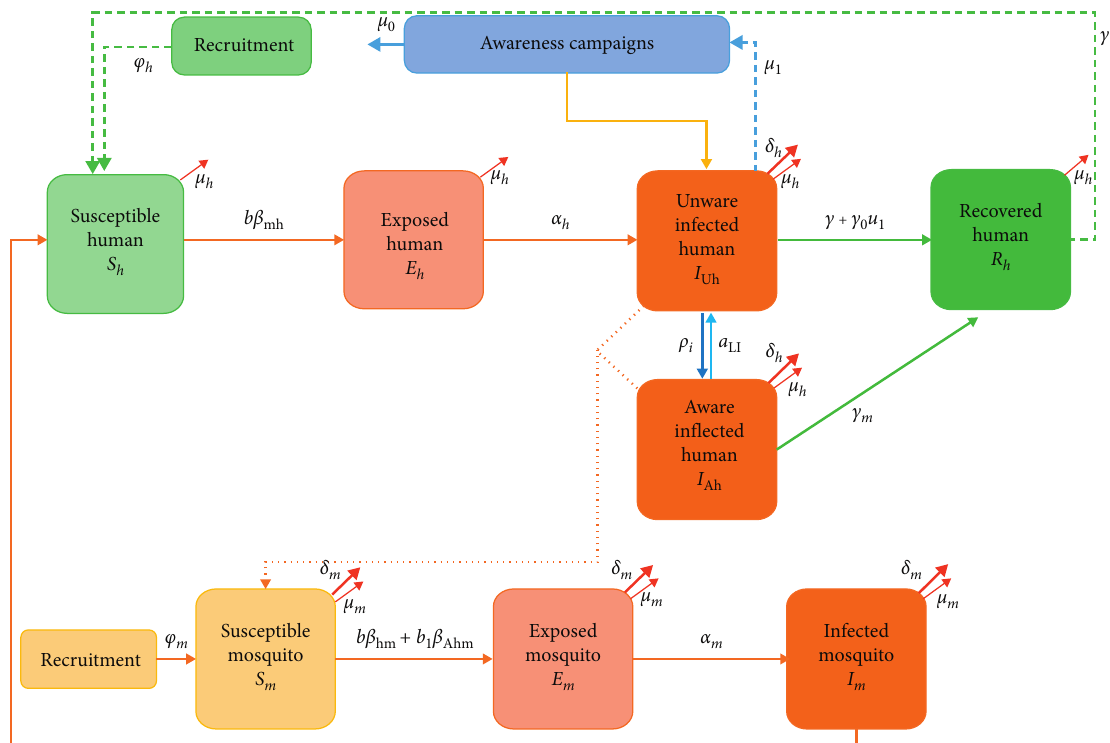
Figure 1: Schematic diagram of the proposed model